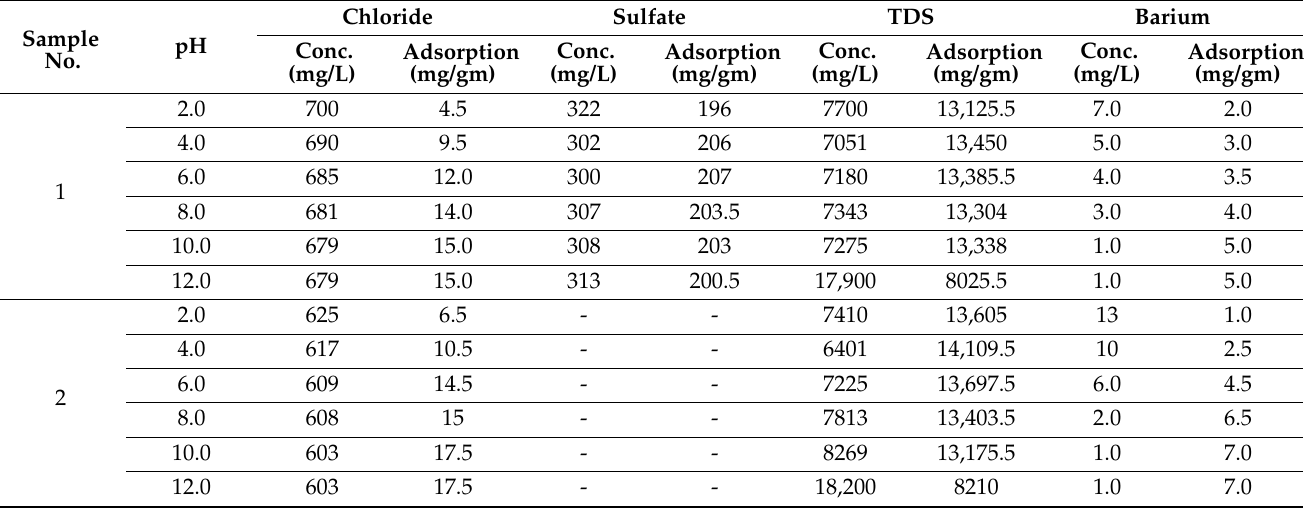
Table 5. Adsorption concentration of chlorides ions in industrial wastewater samples at different pH.